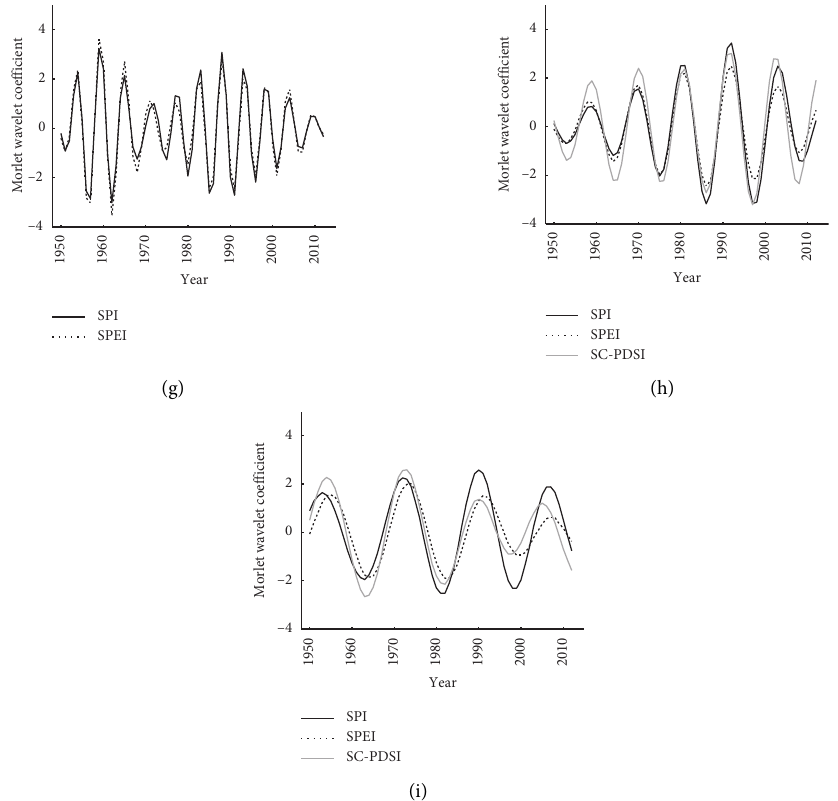
Figure 6: (a–c) Wavelet transformation and (d–f) wavelet variance of the SPI, SPEI, and SC-PDSI, and (g–i) wavelet coefficient during the 8a, 17a, and > 20 a oscillation period in the ARNC from 1950 to